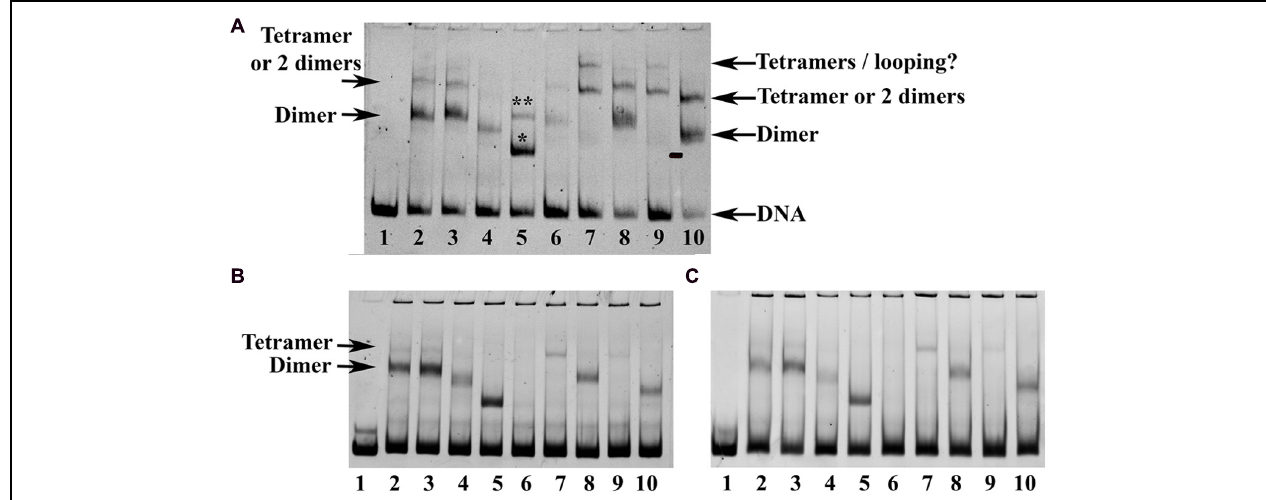
FIGURE 6 | Electrophoretic mobility shift assay (EMSA) for SEP3 and AG. (A) Comparison of the oligomerisation state of SEP3 wild type, dimerisation and tetramerisation mutants with AG using a 121 bp DNA fragment of the SOC1 promoter comprising two CArG boxes. Lane 1 corresponds to DNA alone, lane 2 SEP3 wild type, lane 3 SEP3 L171A , lane 4 SEP3 L115R , lane 5 SEP3 (cid:2) C truncation mutant, lane 6 AG, lane 7 SEP3 + AG, lane 8 SEP3 L171A + AG, lane 9 SEP3 L115R + AG, lane 10 SEP3 (cid:2) C + AG. Putative tetramer and dimer are indicated by arrows. The truncation mutant in lane 5 likely has one or two dimers bound to DNA as